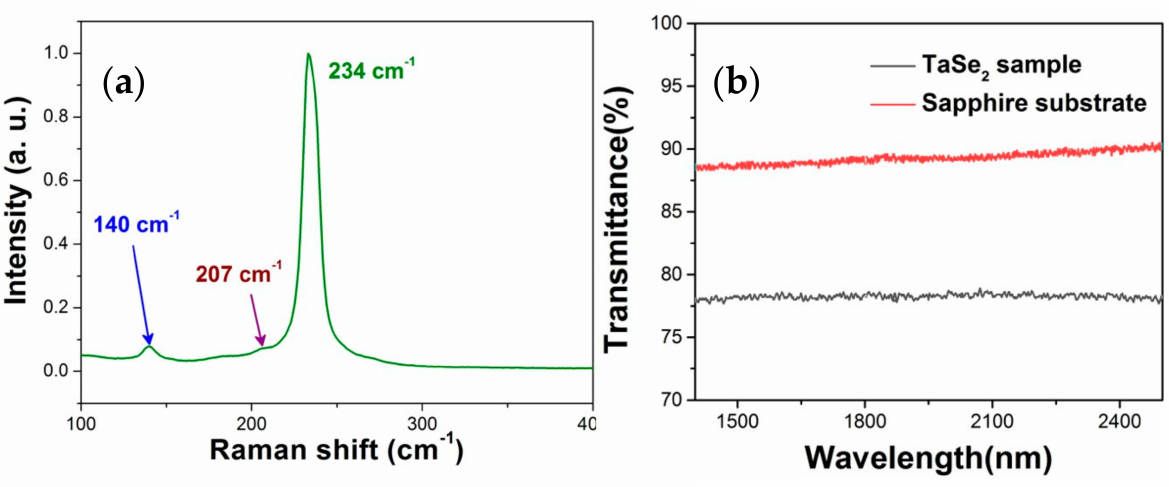
Figure 4. ( a ) Raman data of 2H-TaSe 2 nanosheets. ( b ) Linear transmittance of the sample and sapphire